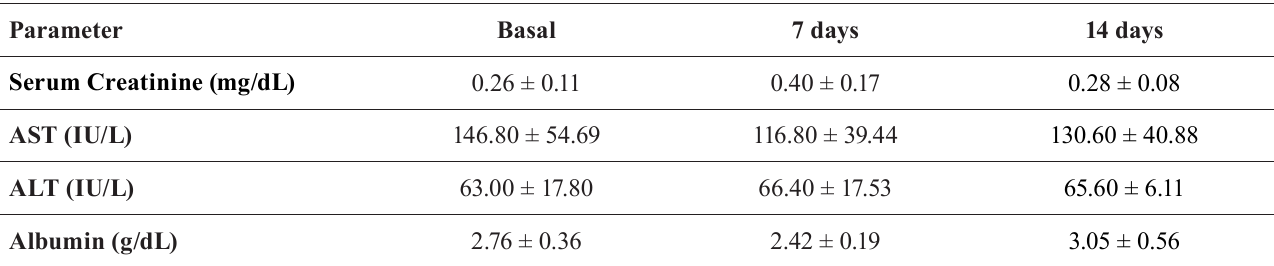
TABLE II - Biochemical parameters observed in Wistar rats (n = 5) at day 0, 7 th and 14 th after diabetes induction